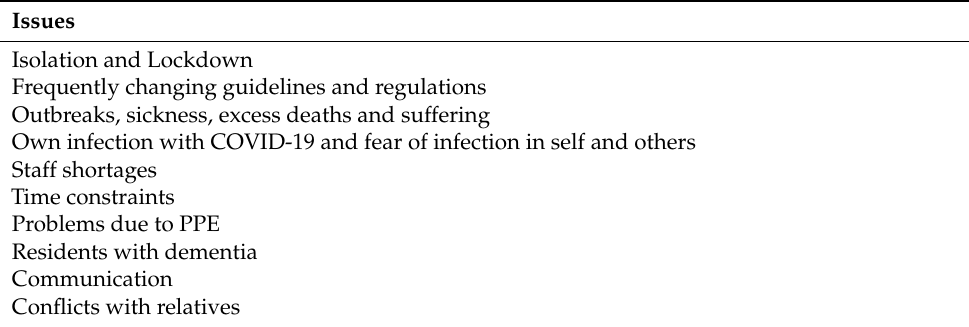
Table 3. Changes in day-to-day nursing work in response to the pandemic